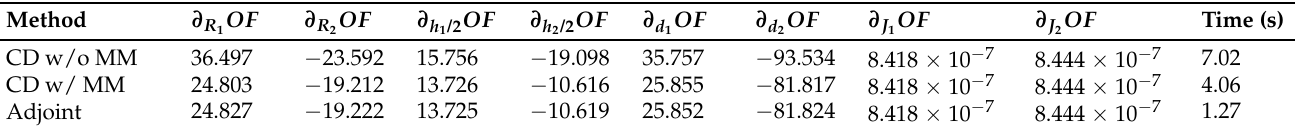
Table 4. Gradient comparison for TEAM Workshop 22.